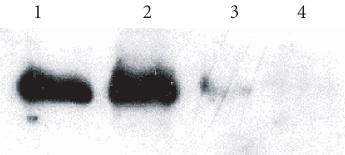
Figure 5: IL-1 β and DEX e ff ects on RA synovial fibroblast cell sur- face annexin I. RA FLS were exposed to IL-1 β 1 ng/mL and DEX 10 − 7 –10 − 8 M for 24 hours. Cell surface annexin I was detected by Western blotting. Lane 1 and 2 show control, and IL-1 β -treated cells, lane 3 and 4 show IL-1 β + DEX (10 − 7 and 10 − 8 M)-treated cells. Cell surface annexin I was increased by IL-1 β . Cotreatment with DEX and IL-1 β inhibited cell surface annexin I. Data presented are from one experiment representative of n = 3.